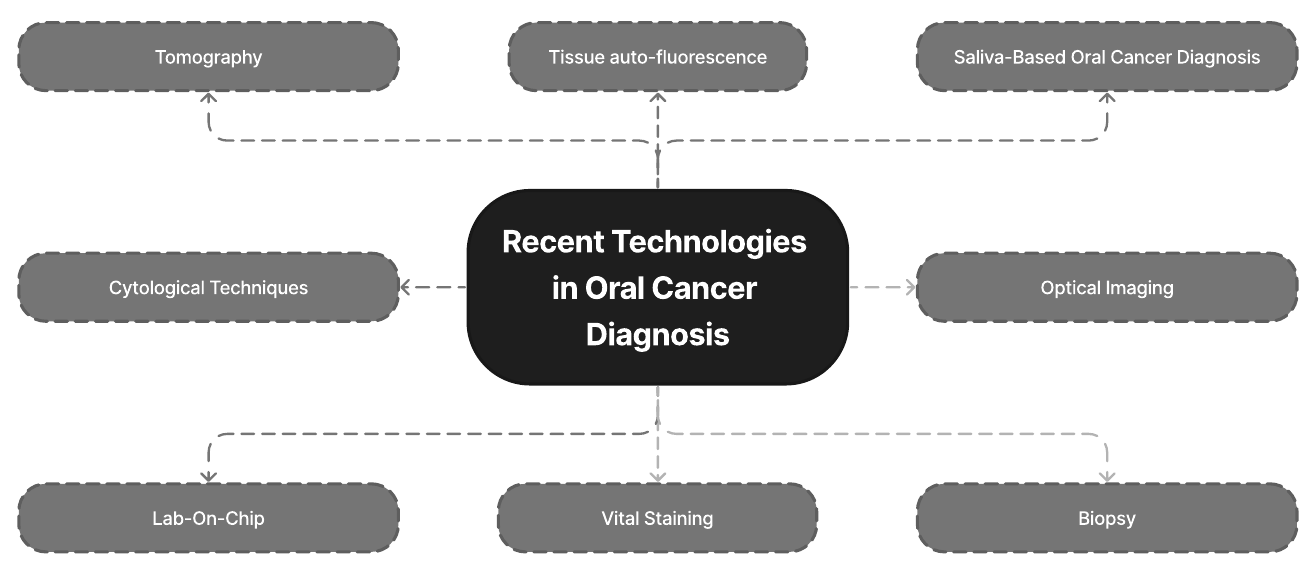
Figure 8. Technologies related to diagnosis of OC.